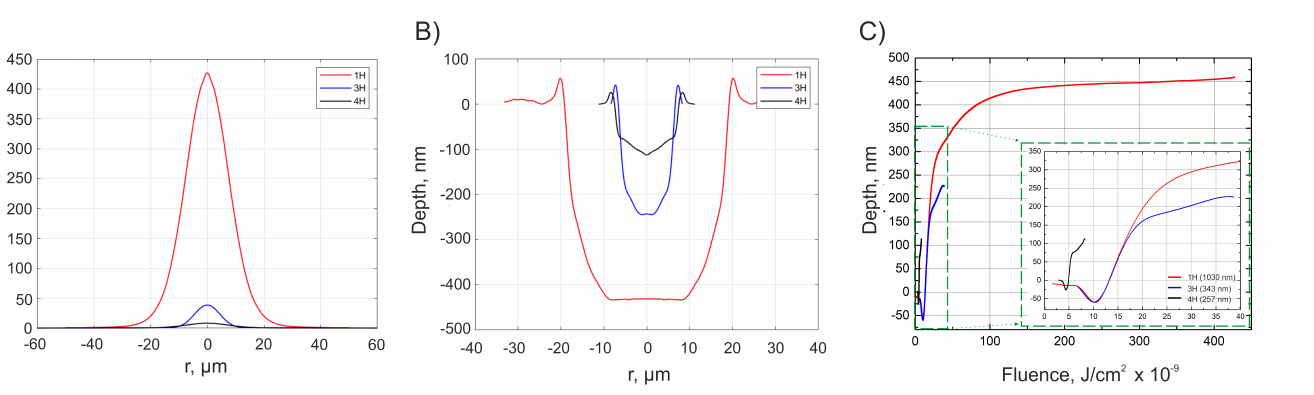
Figure 7. Surface roughness dependence on the overlap of modifications when different laser wavelengths are used ( A ). Surface roughness measured in scanning (x) direction. Solid lines represent experimental results, and dotted lines represent modeling results. In ( B ), a macro picture of machined surfaces (using laser source 1) is shown.